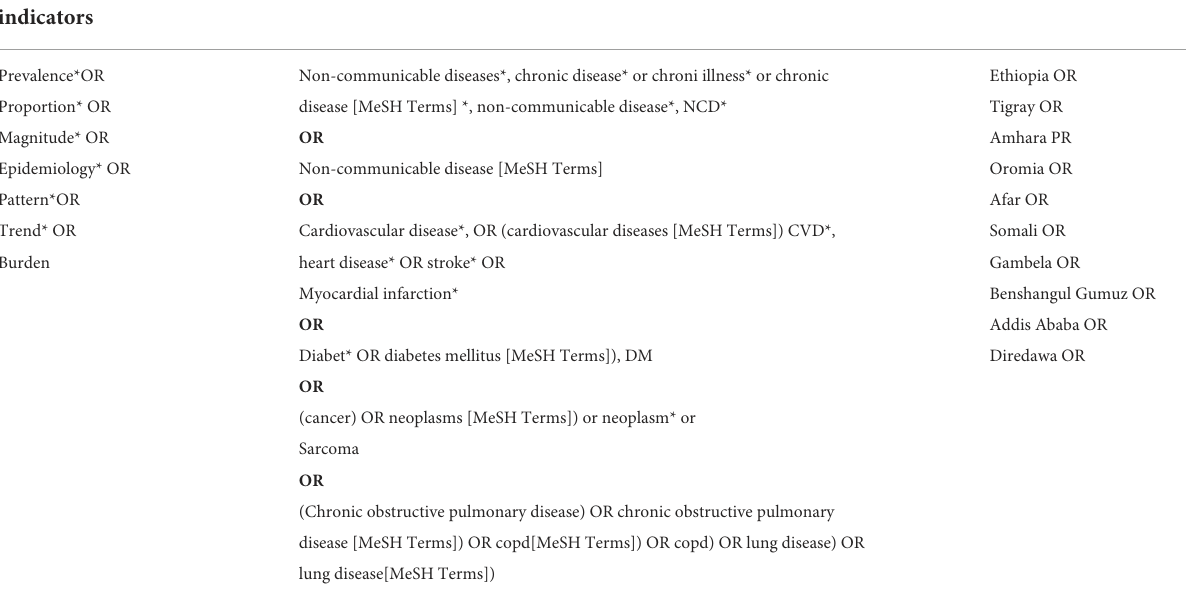
TABLE 1 Systematic search strategy applied across five academic databases from 2012 to July 2020 (e.g., this is the Medline search). Hedge 1: